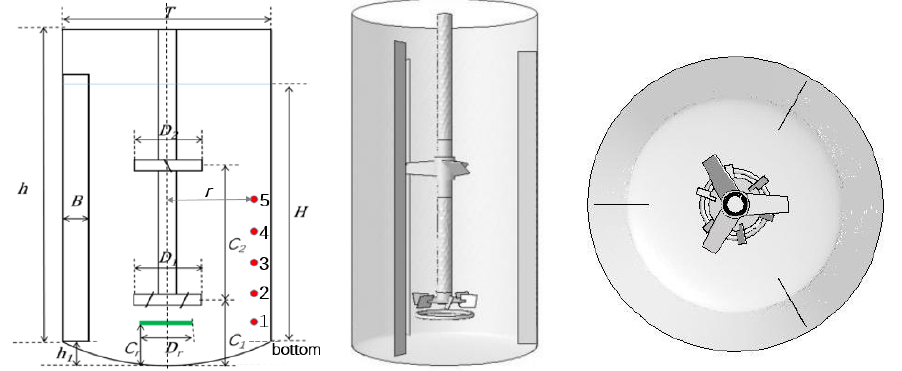
Figure 1. Geometric Structure of Industrial Scale Stirred Reactor. The reactor is a cylindrical cylinder with a diameter of 2500 mm, the height of the reactor is 4500 mm, and the bottom of the reactor is an oval head with a height